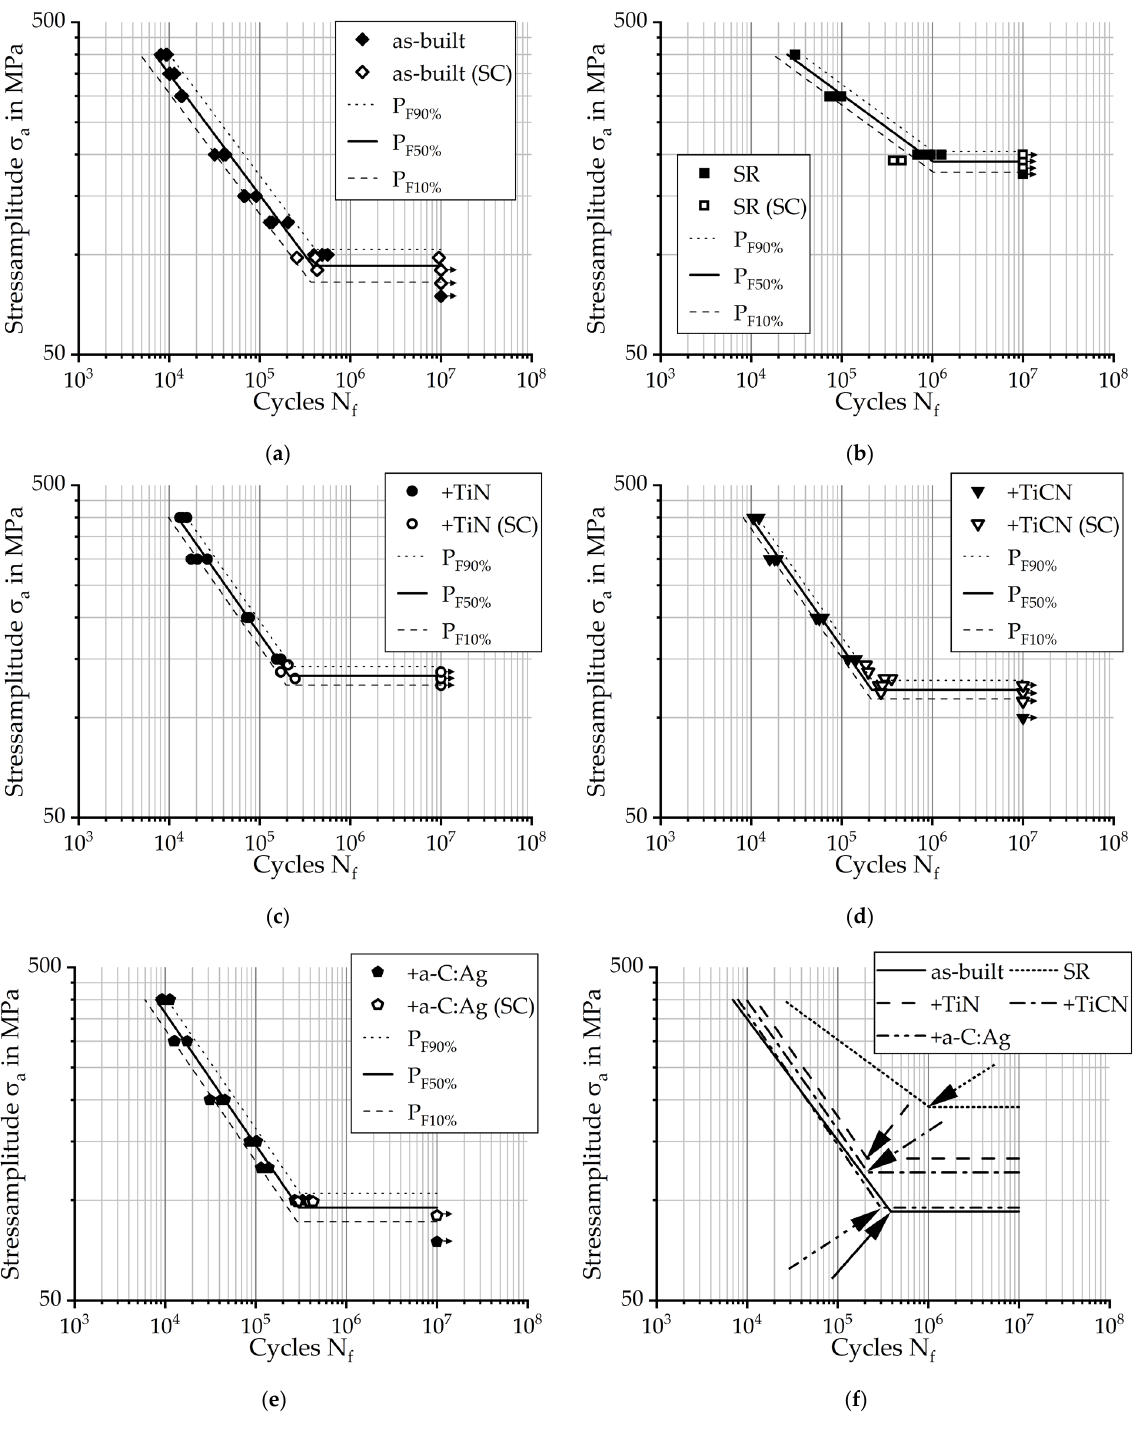
Figure 2. Experimental stress-life curves of the different conditions showing the results of the Wöhler tests (filled symbols) and staircase tests (SC, hollow symbols); failure bands described by the failure probability curves P F10% , P F50% , and P F90% ; horizontal arrows indicate the run-out specimens (after 10 7 cycles); ( a ) as-built condition; ( b ) SR condition; ( c ) PVD coated with TiN; ( d ) PVD coated with TiCN; ( e ) PVD coated with a-C:Ag; ( f ) comparison of the failure probability curves P F50% of the different conditions.